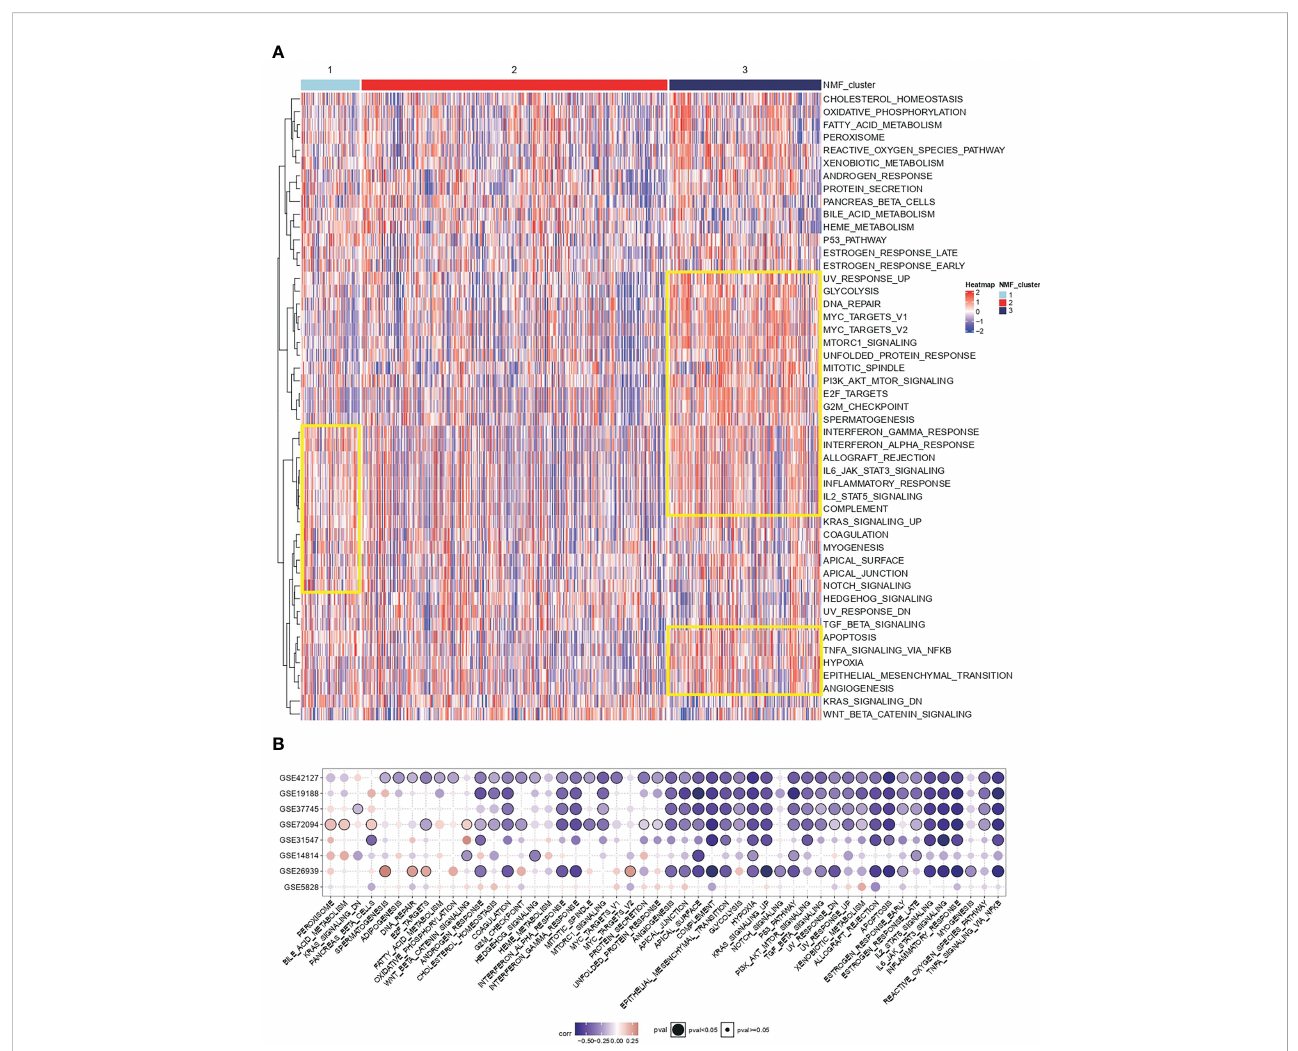
FIGURE 2 Functional resolution of IL-1 molecular typing and IL-1score construction. (A) The respective cancer hallmarks pathway scores among different subgroups of TCGA-LUAD. (B) Correlation of IL-1score with cancer hallmarks pathway scores from eight independent validation